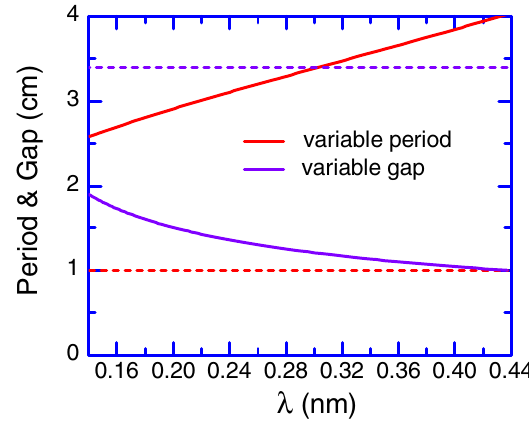
FIG. 6. The period of the VPU and the gap of the variable-gap undulator (solid lines) required to reach the given fundamental wavelength. The red dashed line is the constant gap of the VPU, and the blue dashed line is the constant period of the variable- gap undulator.